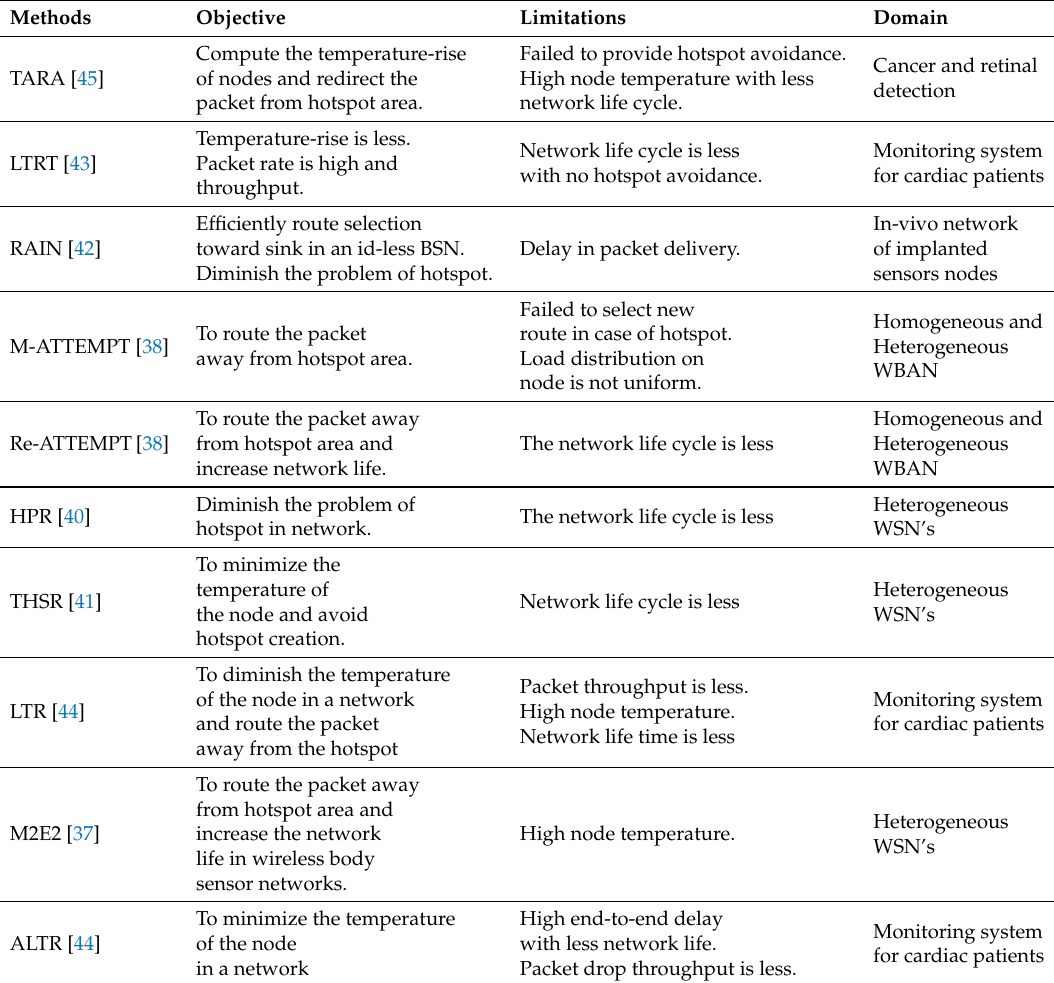
Table 2. State-of-the-art analysis of temperature-aware routing